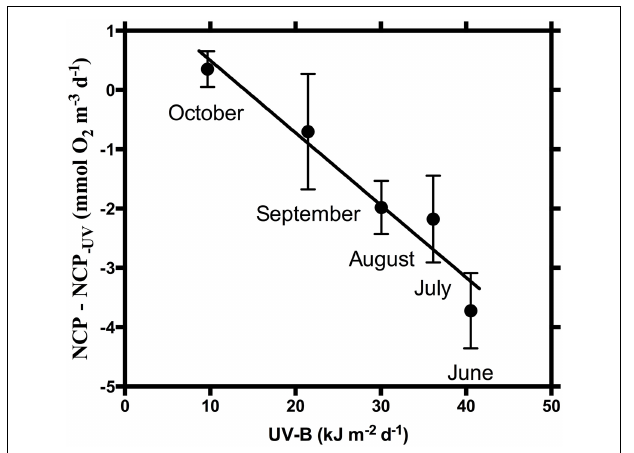
FIGURE 3 | Difference between NCP and NCP − UV (mmol O 2 m − 3 d − 1 ) at in situ temperature vs. daily incident UV-B radiation (kJ m − 2 ). NCP-NCP − UV = 1 . 72 ( ± 0.53) − 0.12 ( ± 0.02) UV-B, R 2 = 0 . 94 , p = 0 . 006 .